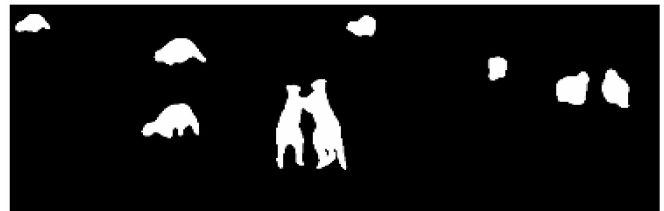
Figure 4. Image binarization in algorithm